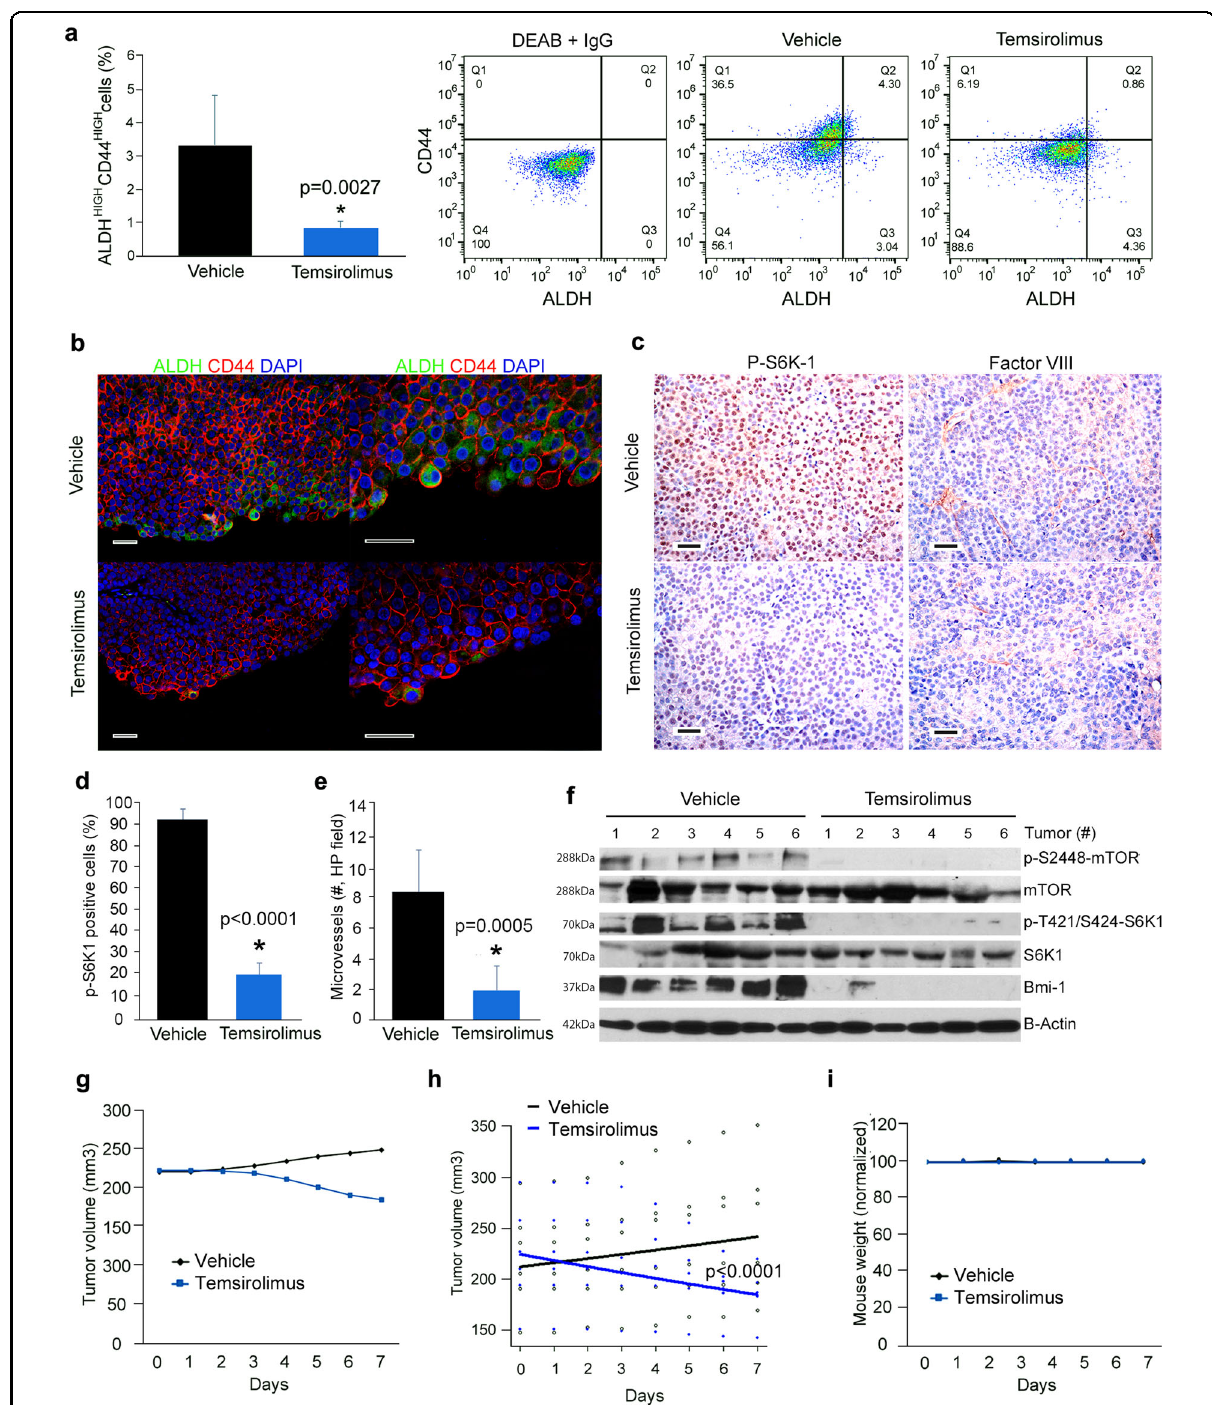
Fig. 5 (See legend on next